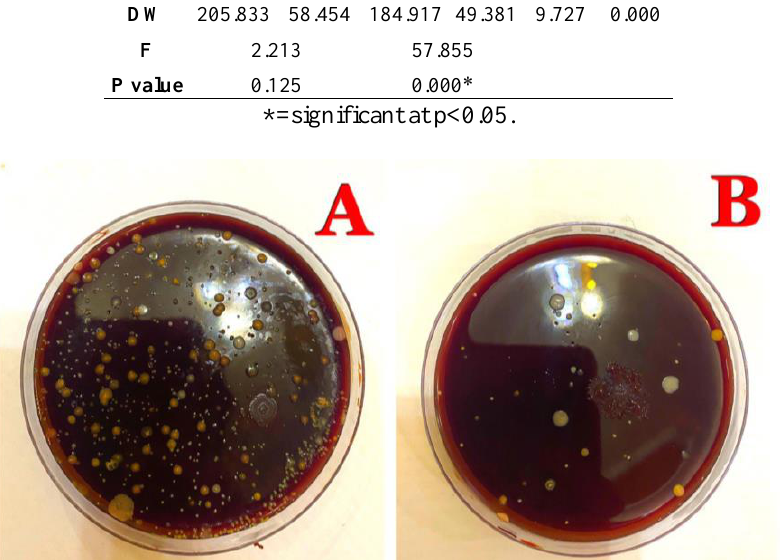
Figure 3: A: Microbial colony growth on agar plate before rinsing at patient chest B: Microbial growth after rinsing with CPC mouthwash at patient chest